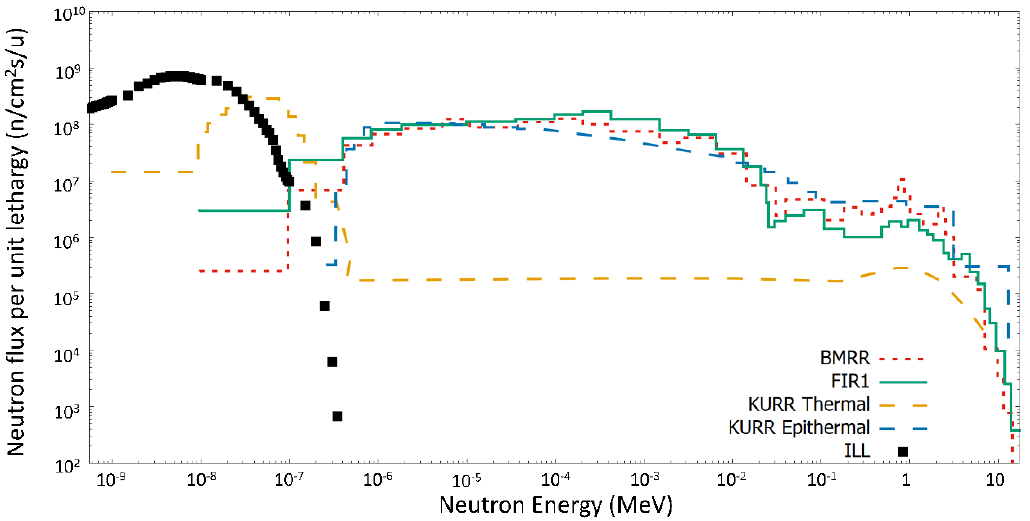
Figure 1. Simulated neutron spectrum at the end of the collimation system of the PF1B line at the Institut Laue-Langevin (ILL) (squares) when compared with neutron Boron Neutron Capture Therapy (BNCT) sources [17,18], such as the epithermal beam of Brookhaven Medical Research Reactor (BMRR), epithermal and thermal beams of Kyoto University Research Reactor Institute (KURR) and the epithermal beam in Finland Reactor 1 (FIR1). Data are expressed in neutron flux per unit of lethargy.